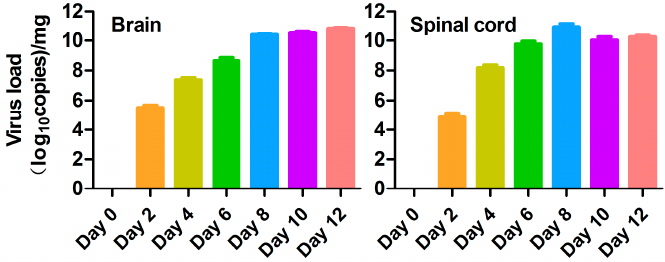
Figure 6. Replicated ZIKV levels in brain and spinal cord of the PRVABC59-infected neonatal C57BL/6 mice. The 1-day-old mice were infected i.p. with 10 6 TCID 50 PRVABC59 per mouse for different days as indicated. The mice were then dissected after euthanasia at 0, 2, 4, 6, 8, 10 and 12 dpi to isolate the organs and tissues as indicated: brain and spinal cord. Real time RT-PCR was performed to determine the ZIKV RNA level in the isolated or collected organs and tissues. For each length of time kept, we used three mice. The average number of the RNA copies from the real time RT-PCR was obtained statistically with GraphPad Prism Software version 5.01. (The statistical significance was not determined. The graph only showed the means ± S.D.).